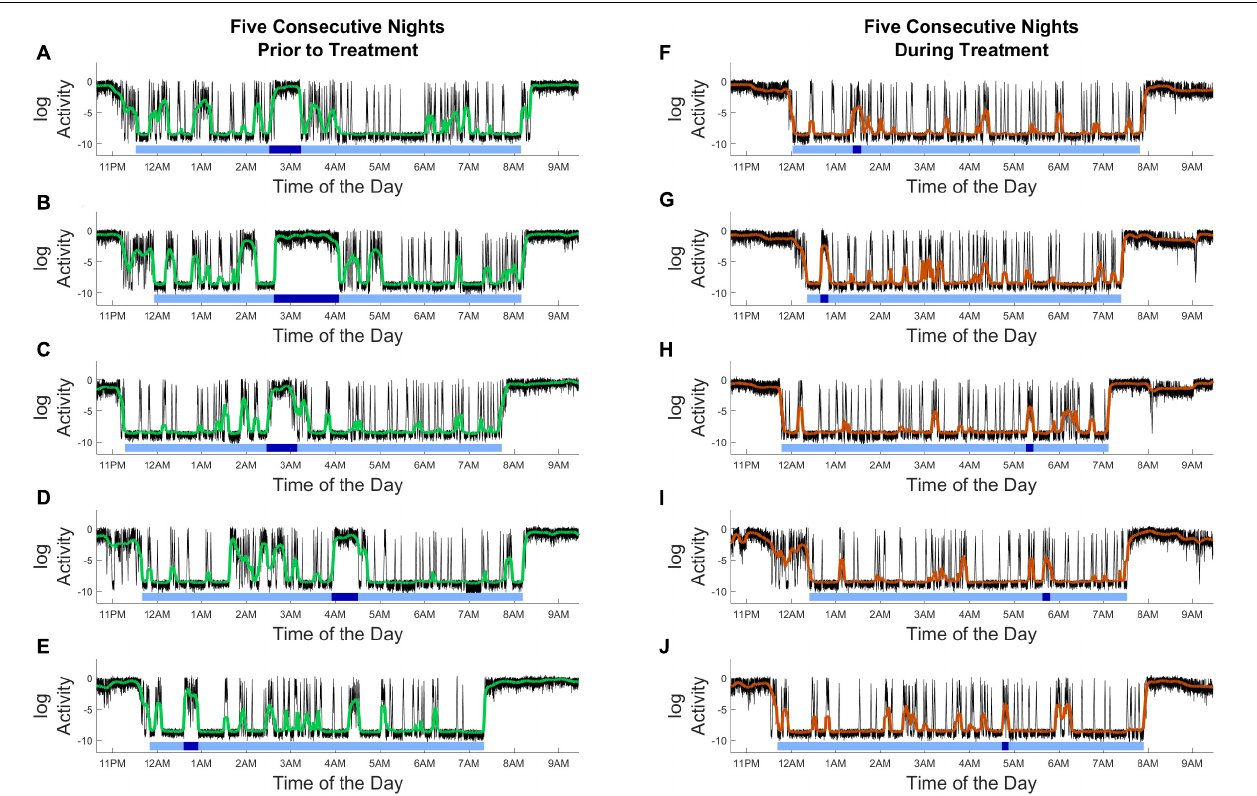
FIGURE 3 | Actigraphy recordings from a single patient demonstrating the effects of gamma sensory stimulation therapy on nighttime active and rest periods. (A–E) Five consecutive nights prior to treatment, (F–J) five consecutive nights during treatment period. Level of continuous activity is shown by the black tracing; median filtered activity levels are indicated by green (A–E) and brown (F–J) curves. The applied analysis identified nighttime active and rest periods: denoted sleep periods are marked by horizontal light blue bars, and the longest movement periods during nights are indicated by the dark blue bars. Compared to the pre-treatment period, fewer and shorter movement periods are observed. X -axis shows the time of day, Y -axis shows the activity level (in log